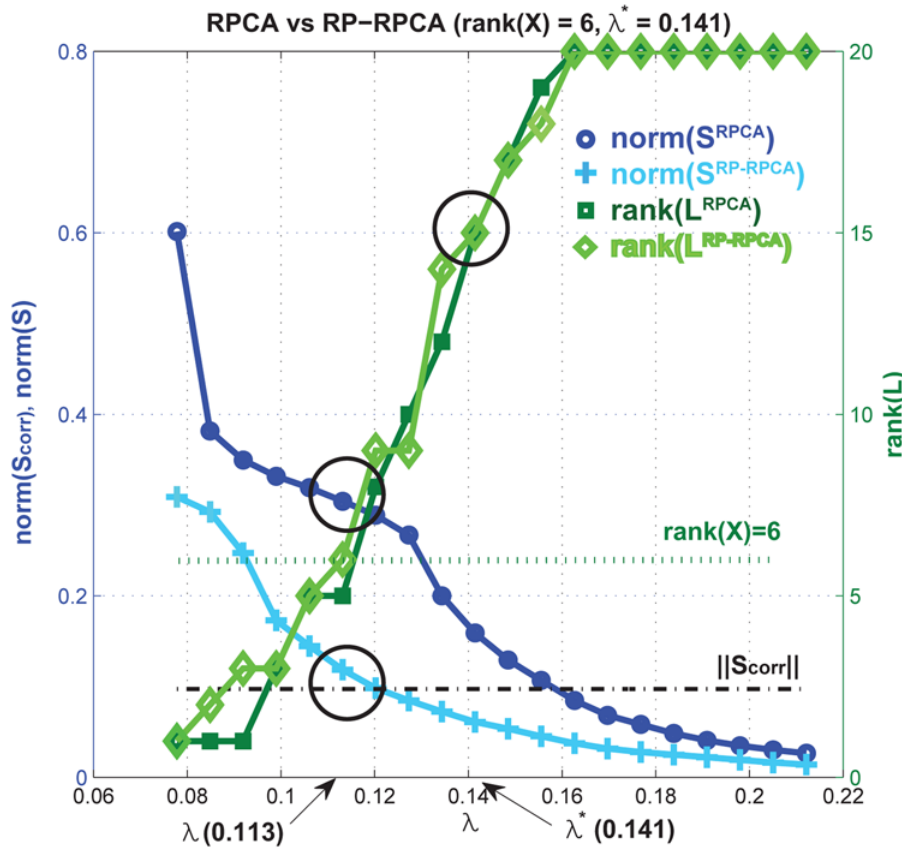
(more detailed information in S1 Fig. and S2